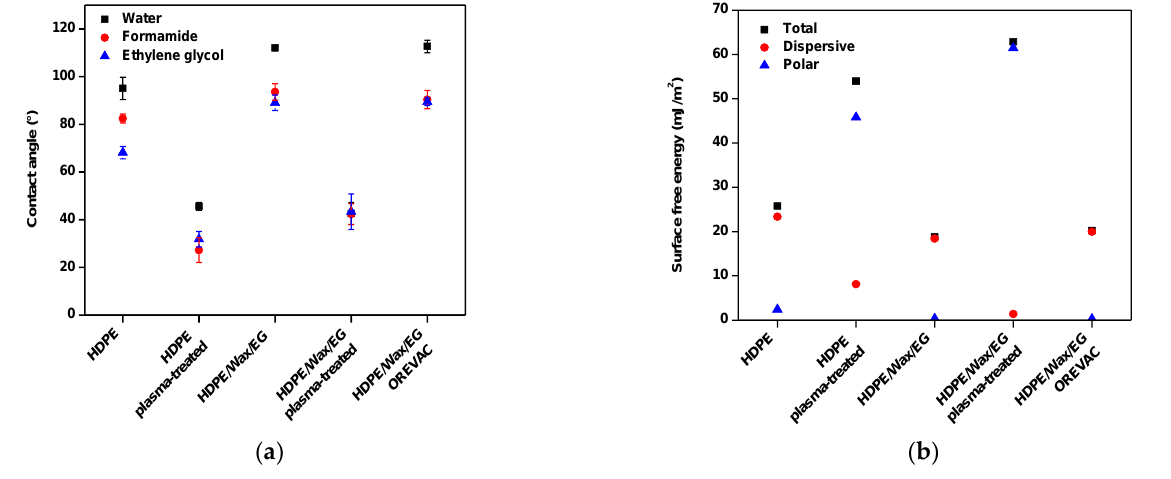
Figure 7. Wettability analyses of SSPCMs: ( a ) Contact angle; ( b ) Surface free energy.